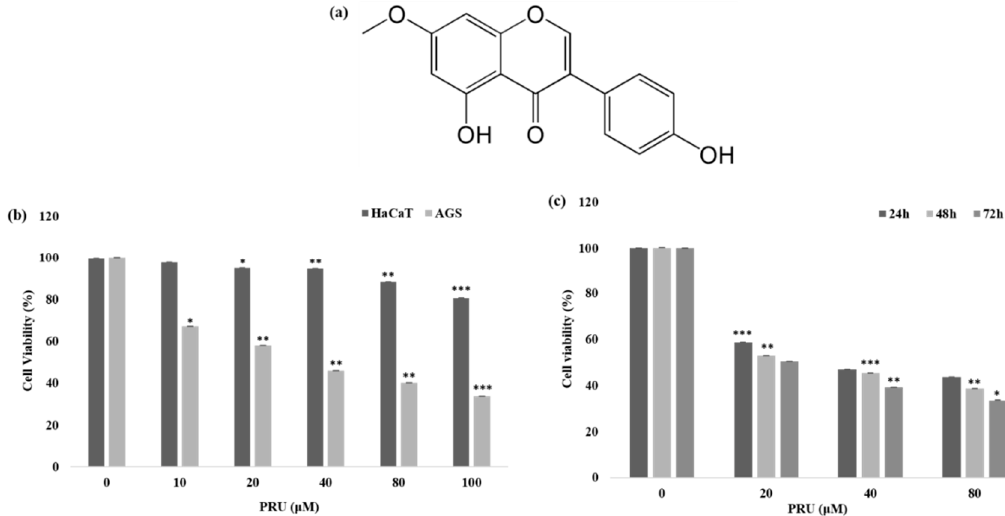
Figure 1. Cytotoxic properties of the compound prunetin (PRU). ( a ) Chemical structure of the compound PRU. ( b ) Plot of cell viability measured by MTT assay on AGS cancer cells and human keratinocytes, and HaCaT cells with various concentrations of PRU (0, 10, 20, 40, 80, and 100 µ M) respectively. Cell viability is represented in percentage relative absorbance compared to the controls. ( c ) Plot of cell viability measured by MTT assay on AGS cancer cells at three indicated concentrations (20, 40, and 80 µ M) at three di ff erent time intervals from 24, 48, and 72 h respectively. Values are given as the mean ± standard error of the mean (SEM) of three independent experiments. * p < 0.05 vs. control, ** p < 0.01 vs. control, *** p < 0.001 vs. control.